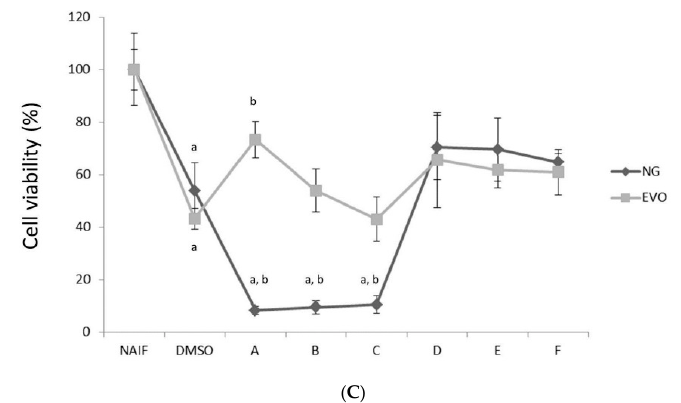
Figure 2. Cytotoxicity of the oils at different times, 24 h ( A ), 48 h ( B ), 72 h ( C ) and concentrations. The x axis shows the different concentrations of thymoquinone (A: 100 μ M, B: 50 μ M, C: 10 μ M, D: 5 μ M, E: 1 μ M, F: 0.5 μ M) contained in the Nigella sativa (NG) oil. Equivalent volumes of extra virgin olive (EVO) oil were tested with the same conditions. Statistically significant differences are indexed as follows: a = p < 0.01 vs. NAIF, b = p < 0.01 vs. DMSO.